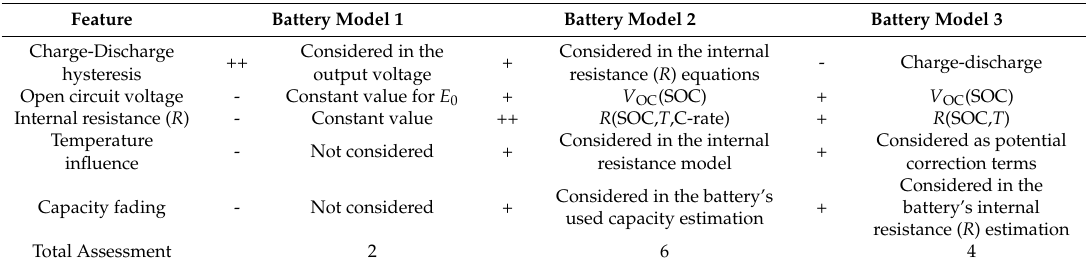
Table 2. Comparison between the battery